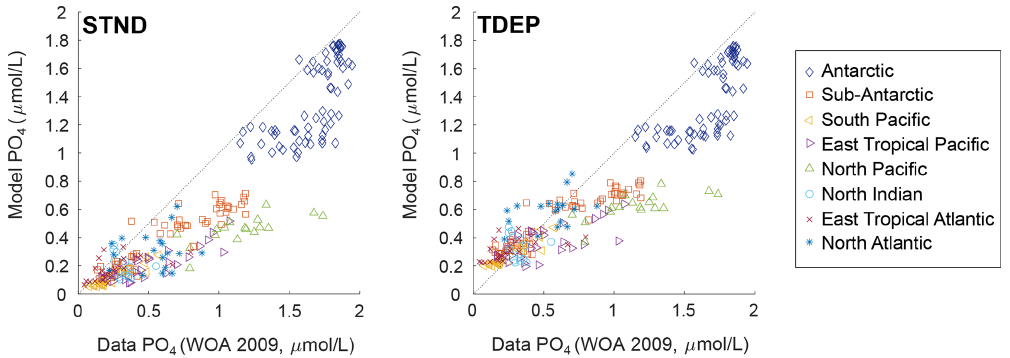
Figure 6. Cross-plot for surface (0 to 80m) PO 4 concentrations (µmolL − 1 ) for the data and model labelled by ocean region. Data from WOA 2009 (Levitus et al.,